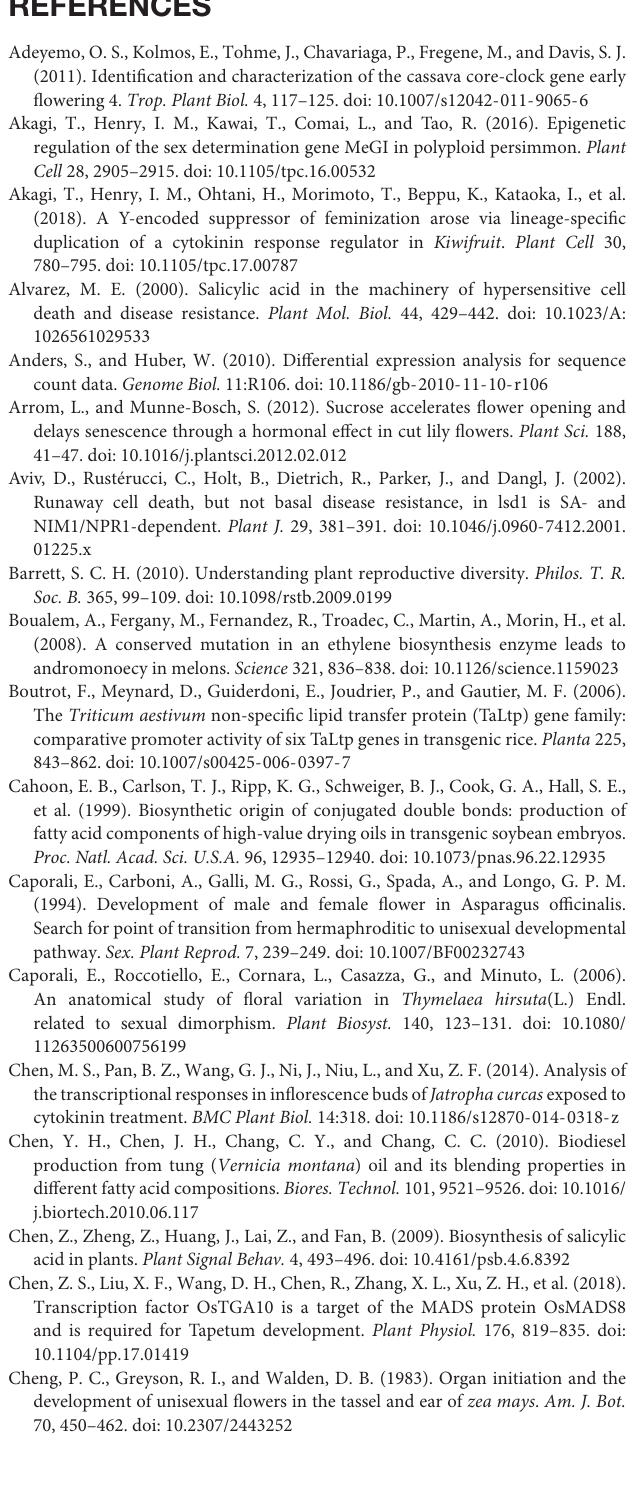
TABLE S2 | KEGG enrichment analysis of DEGs in male and female flowers. TABLE S3 | Stage-specific genes analysis in male and female flowers. TABLE S4 | Expression patterns of anther and pollen development genes in male and female flowers.